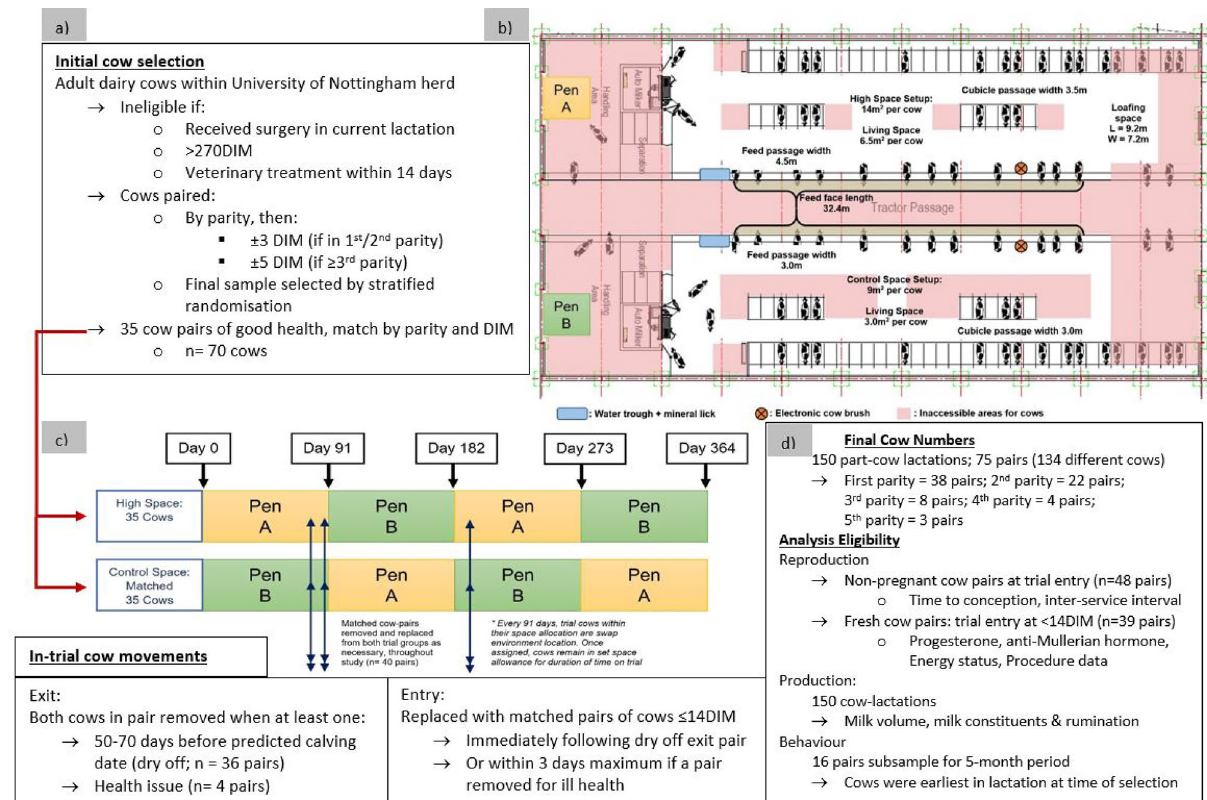
Figure 5. Schematic of a long-term randomised controlled trial study design to evaluate the impact of living space on housed dairy cows, including: ( a ) cow-selection (DIM: days in milk)); ( b ) cubicle shed floorplan with associated space comparisons (red areas inaccessible to cows during trial conditions); ( c ) Cross-over schematic detail cows entry and exit; ( d ) sample size and analysis